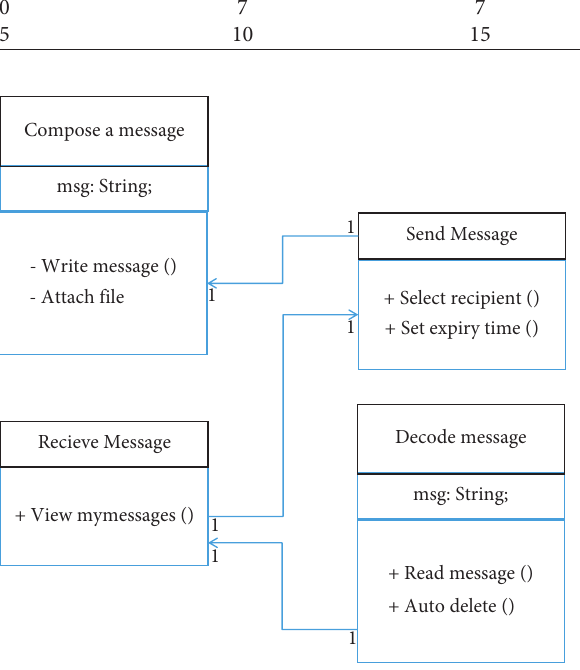
Figure 2: Class diagram of the autodelete